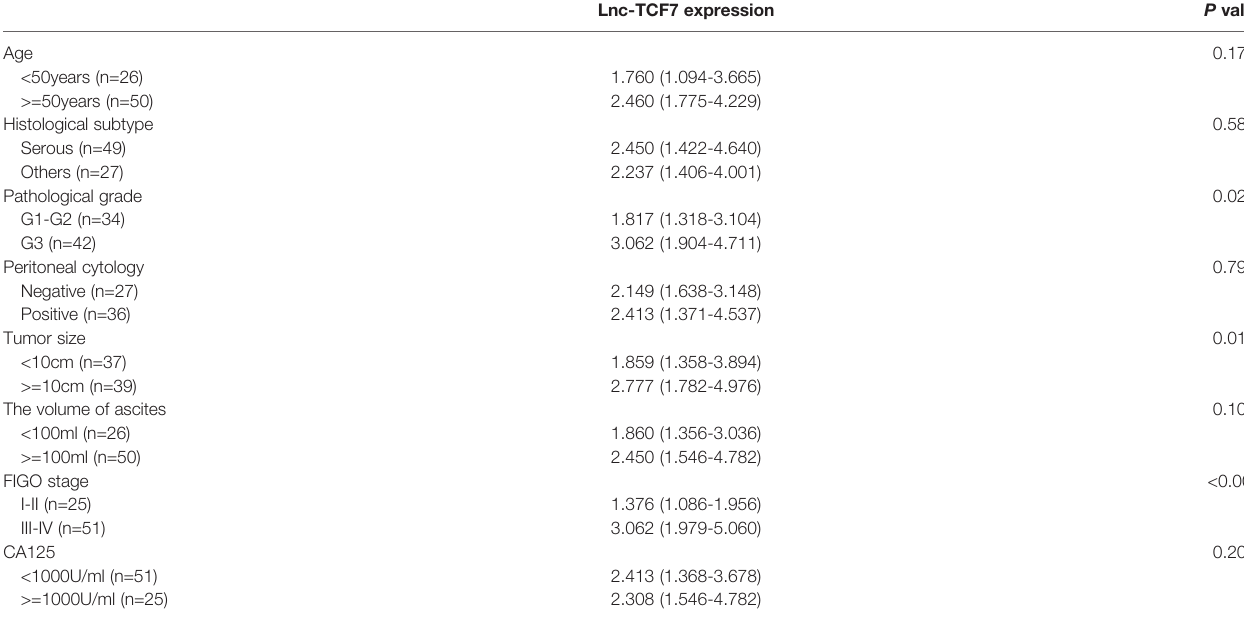
TABLE 1 | Correlation of Lnc-TCF7 expression with clinicopathological